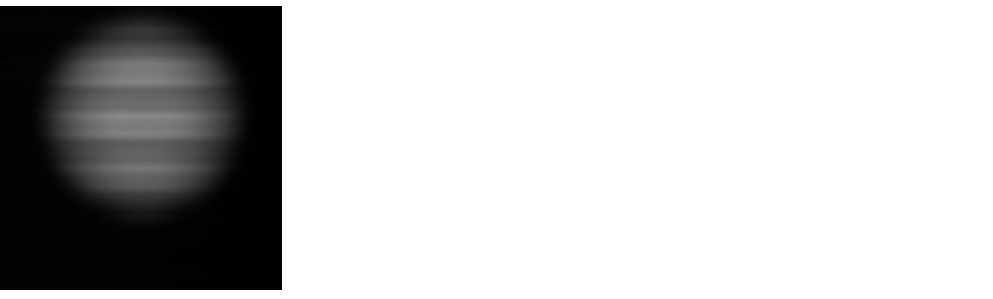
4 pixels, the success rate of UID decoding using the traditional Zbar-based decoder falls